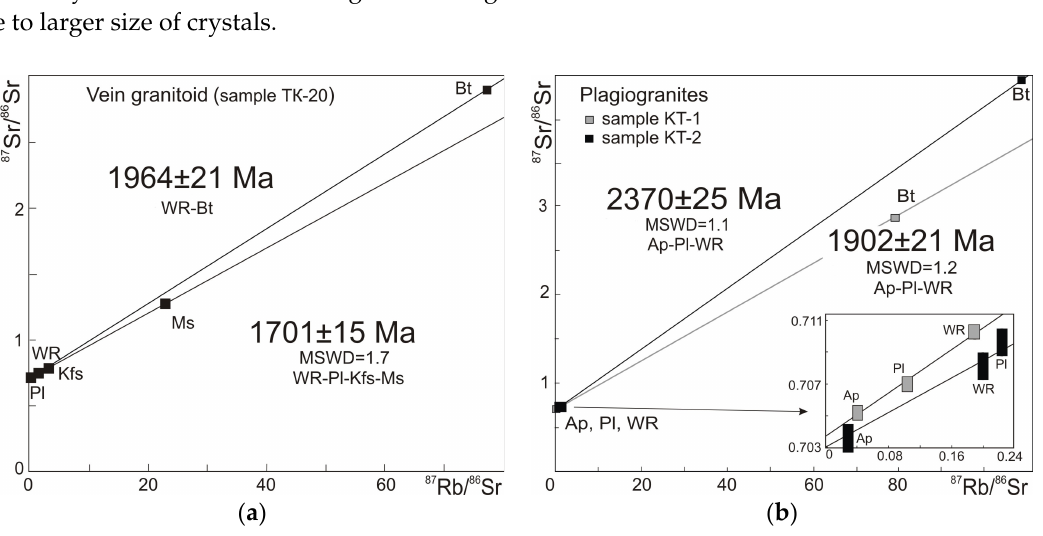
Figure 3. U-Pb isotope data for monazite and uraninite from vein pegmatoid granitoids of the Dikoe occurrence of the Litsa area.